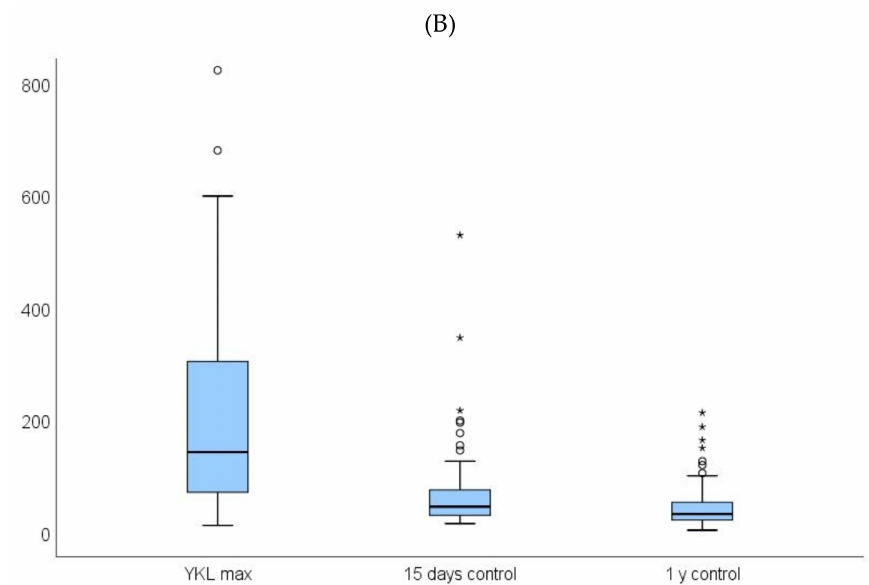
Figure 1. ( A ) The trend of YKL-40 levels during the acute phase in relation to the onset of fever. ( B ) YKL-40 levels during hospitalization (maximum), fifteen days and one year after the hospitalization. Outliers have been omitted from the figure.